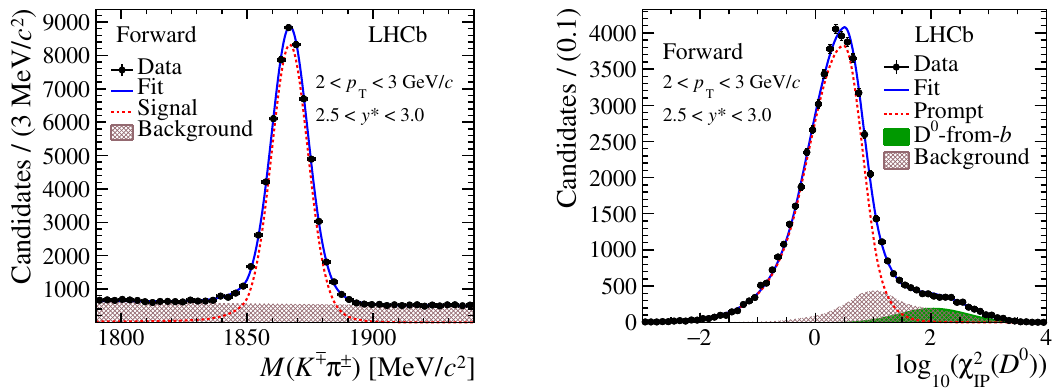
( (cid:31) 2 ( D 0 )) distributions and the (cid:12)t result for the 10 IP